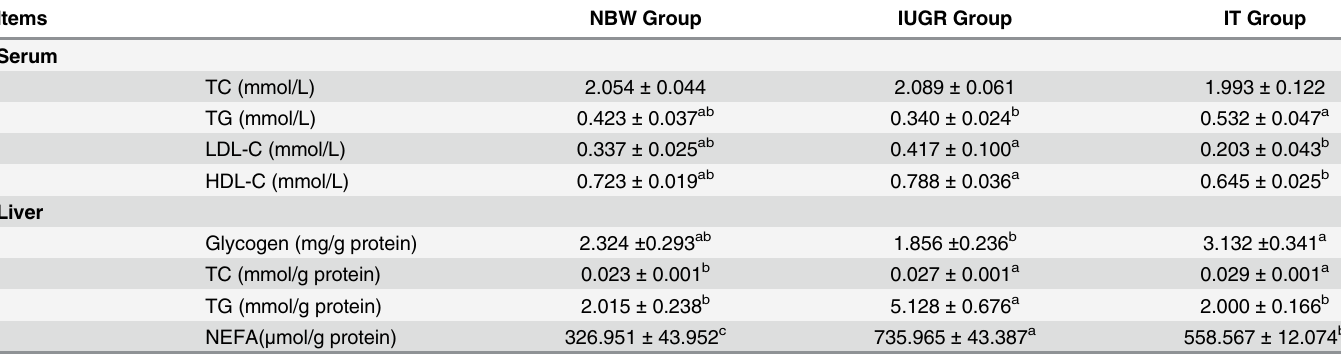
TC, total cholesterol; TG, triglycerides; LDL-C, low-density lipoprotein cholesterol; HDL-C, high-density lipoprotein cholesterol; NEFA, non-esteri fi ed fatty acid. Data are expressed as mean ± SEM, n = 6. SEM, standard error of mean. a,b,c Mean values within a line with different superscript letters were signi fi cantly different ( P < 0.05). NBW, piglets with normal birth weight that were fed with basic milk diets; IUGR: piglets with intrauterine growth retardation that were fed with basic milk diets; IT, piglets with intrauterine growth retardation that were fed with diets supplemented with 0.1% tributyrin.